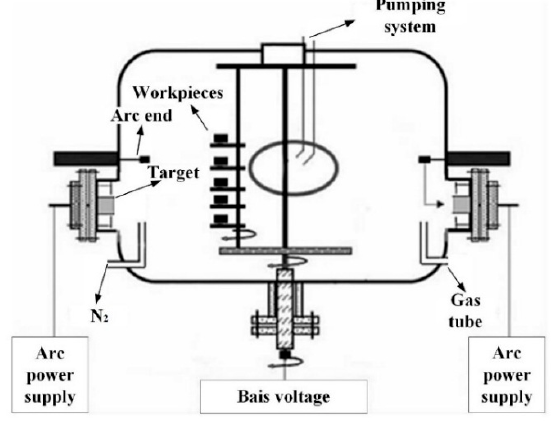
Figure 2. Schematic image of the deposition chamber.